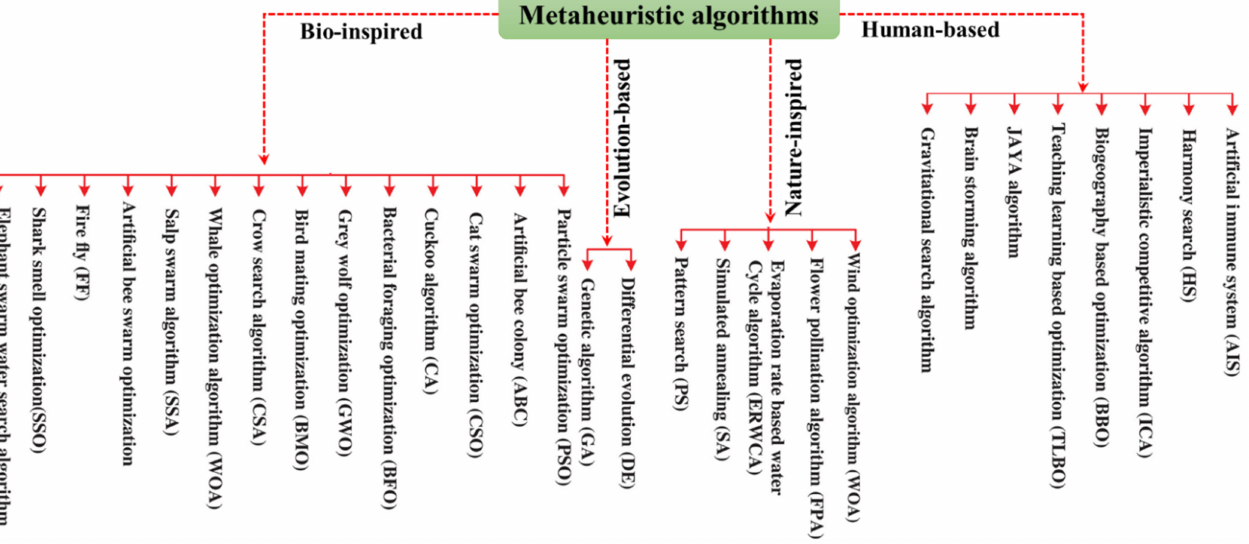
Figure 1. Different metaheuristic methods for assessment of unknown parameters of PV cells or modules (adapted with permission from Ref. [13]. Copyright 2022 John Wiley and